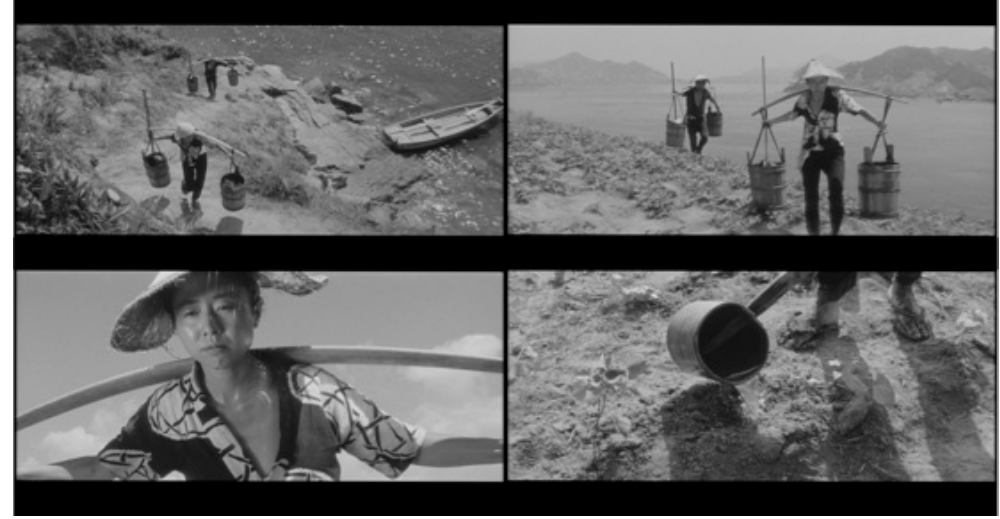
Figure 1. The Naked Island (Shind ō Kaneto, 1960).